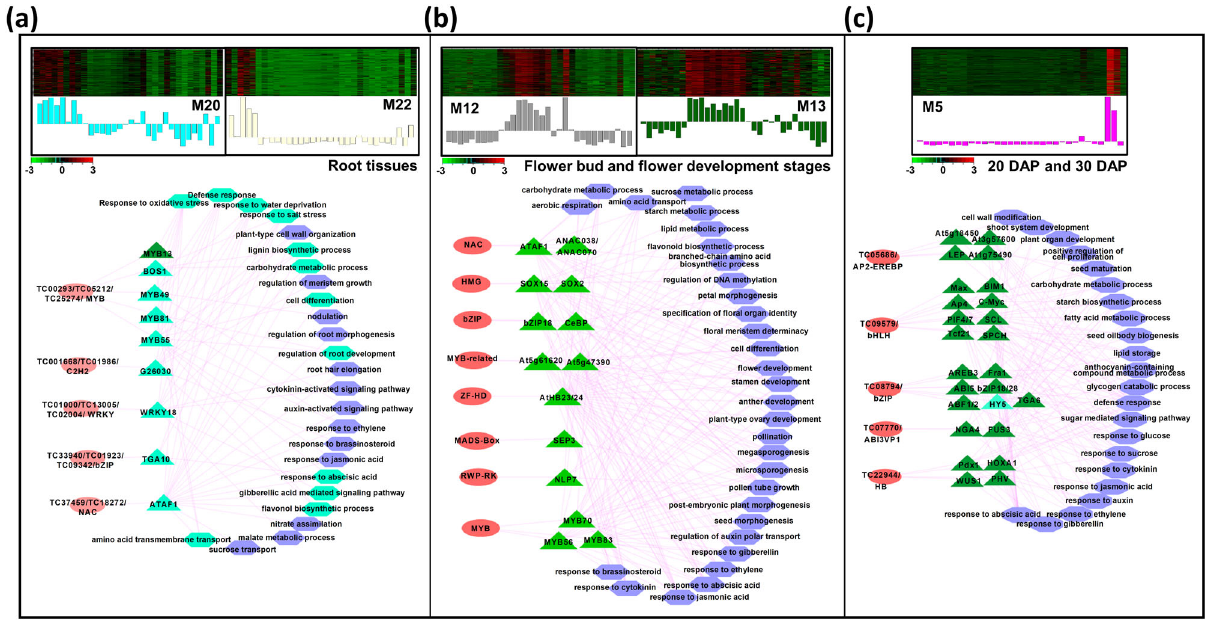
Fig. 5 Expression pro fi le and transcriptional regulatory network associated with modules correlated to multiple tissues or stages of development. Heatmaps show the expression pro fi le of all the coexpressed genes in the module(s) correlated with multiple tissues, including root tissues ( a ), fl ower bud and fl ower development stages ( b ), and 20DAP and 30DAP stages of seed development ( c ). Color scales represent Z -score. Bar graphs (below the heat maps) show the consensus expression pattern of the coexpressed transcripts in each module. The predicted transcriptional regulatory network (signi fi cantly enriched TF-binding sites along with the associated TFs and GO terms) associated with the transcript sets in the modules are shown below the heatmaps. The signi fi cantly enriched cis-regulatory motifs only in protein-coding genes (PCGs), and both PCGs and lncRNAs are shown by green and sea green triangles, respectively. The associated GO terms only in PCGs, and both PCGs and lncRNAs are shown by blue and sea green hexagons, respectively. The TFs are represented by pink ovals. Edges represent known interactions between the cis-regulatory motifs and transcription